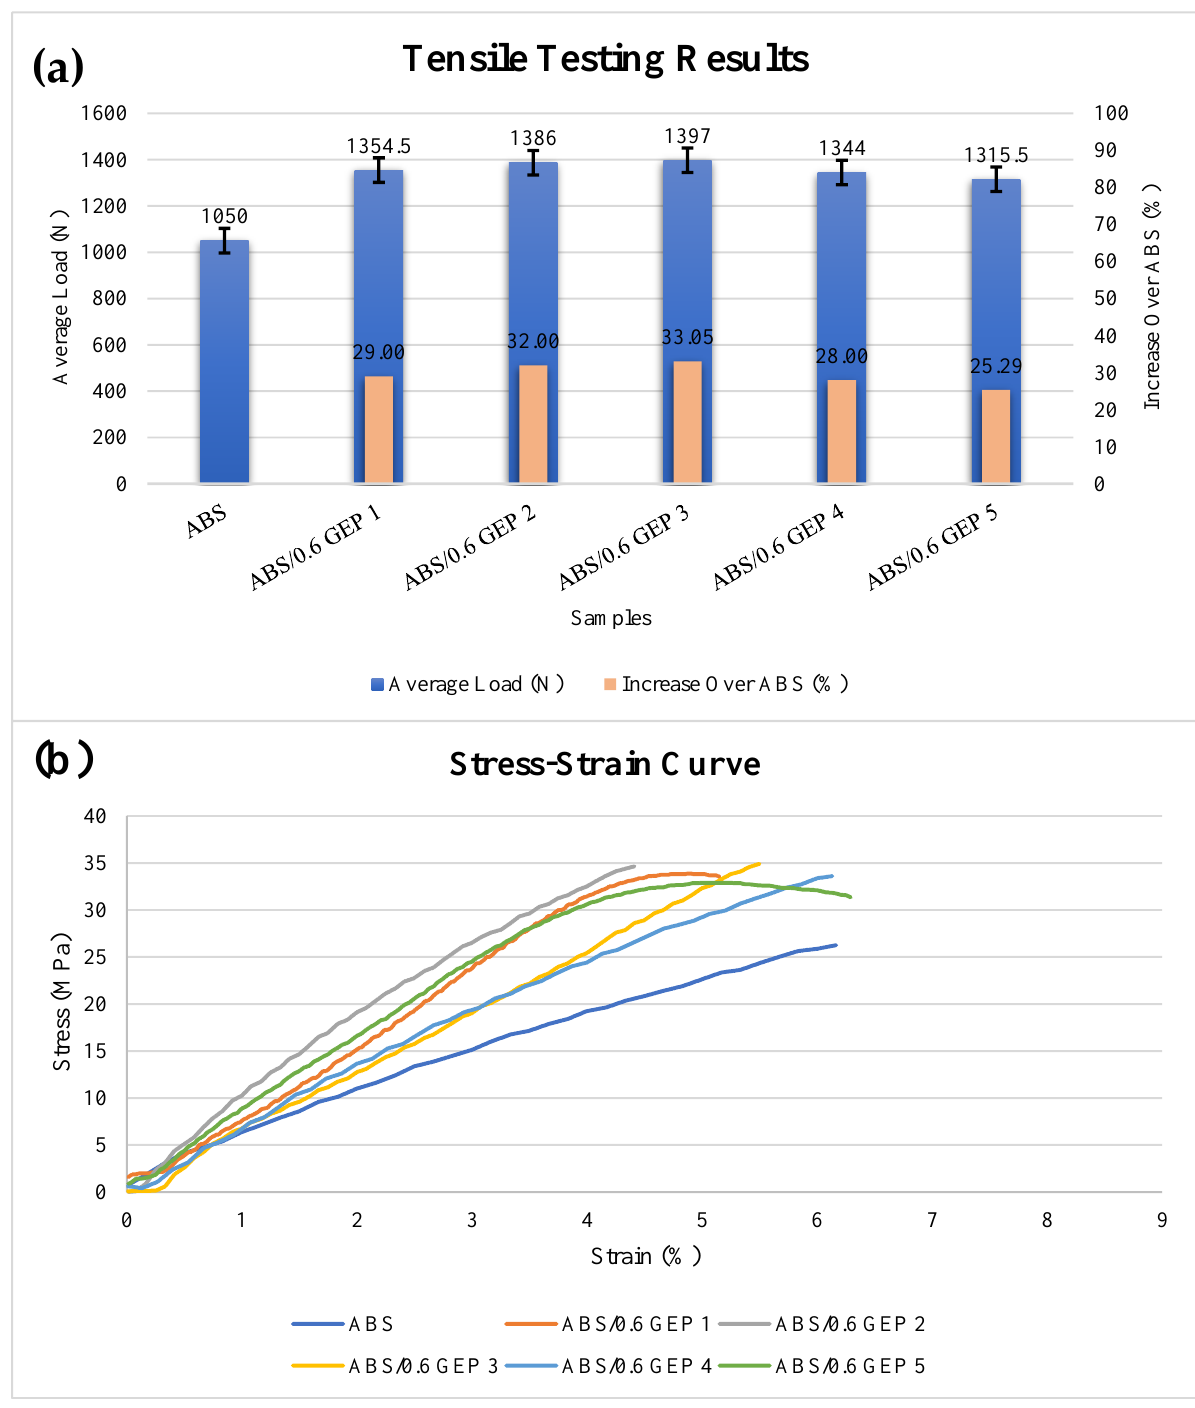
Figure 17. Comparative tensile test results for ABS/0.6 GEP composites: ( a ) results from tensile testing with standard deviation as error bars; ( b ) stress-strain curve.